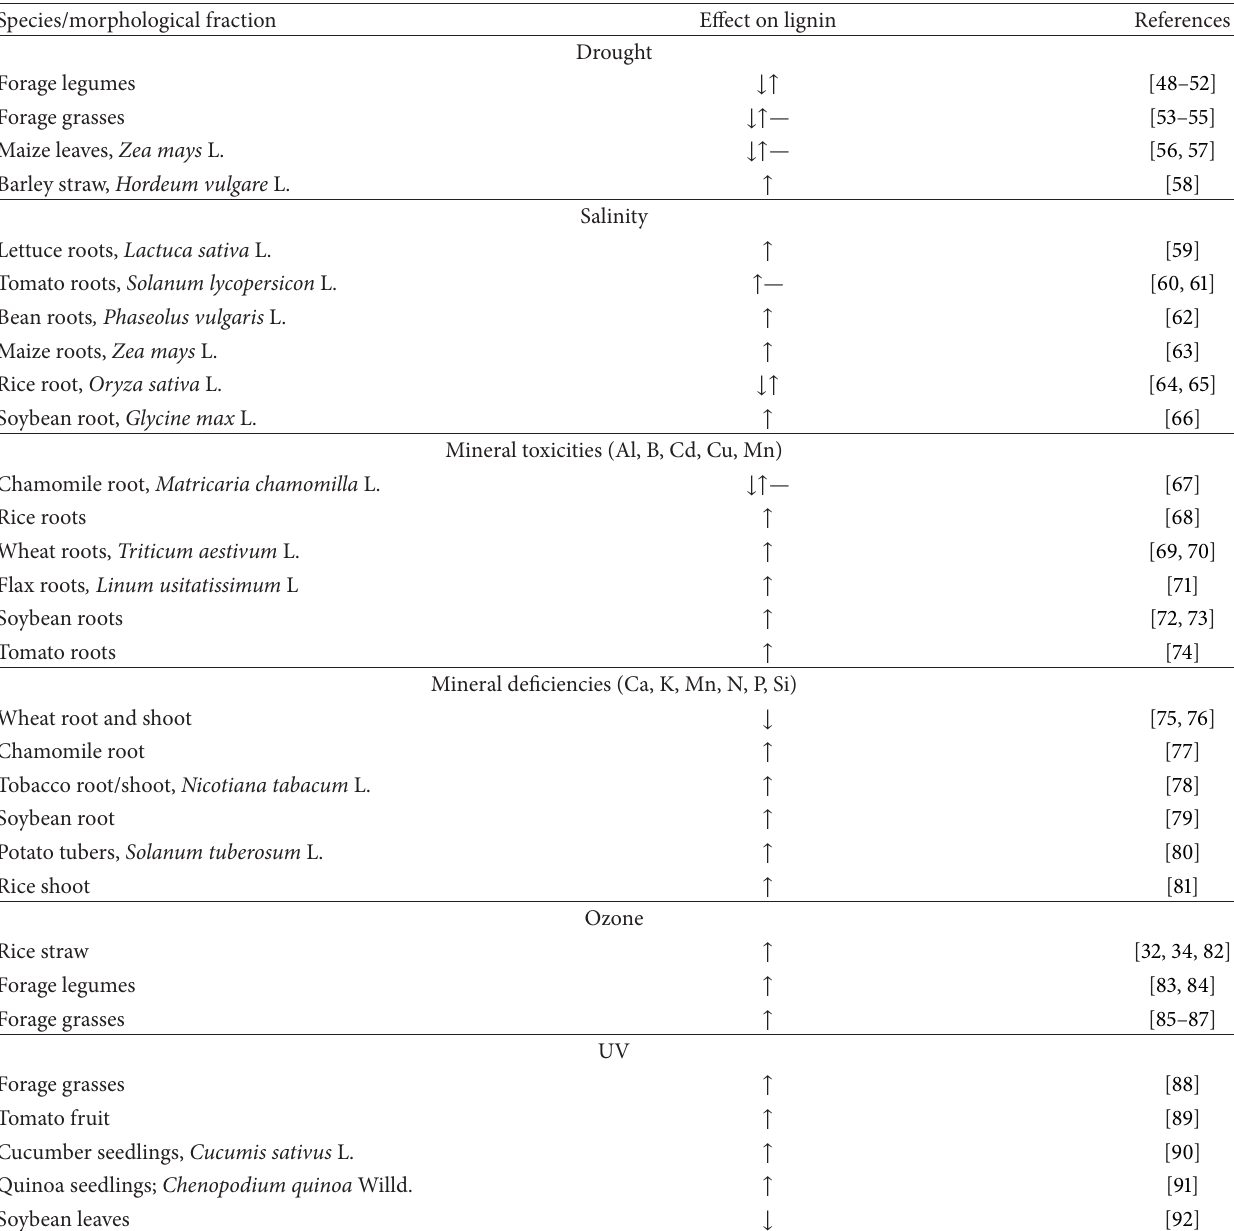
Table 1: Effect of abiotic stresses on lignin concentration of different morphological fractions of